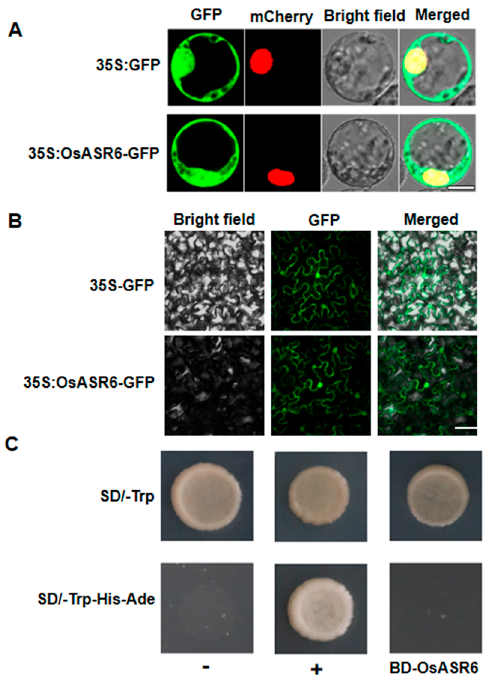
Figure 1. Expression profiles of OsASR6 . Inducible expression pattern of OsASR6 in ( A ) the roots and ( B ) the shoot under ABA, H 2 O 2 , and NaCl stresses treatment. Rice Actin1 was used as an internal control for qRT-PCR analysis. Asterisks indicate significant difference compared to the transcription level of 0 h groups. Three independent experiments were performed. Data represent means ± SD. * p < 0.05, ** p < 0.01.